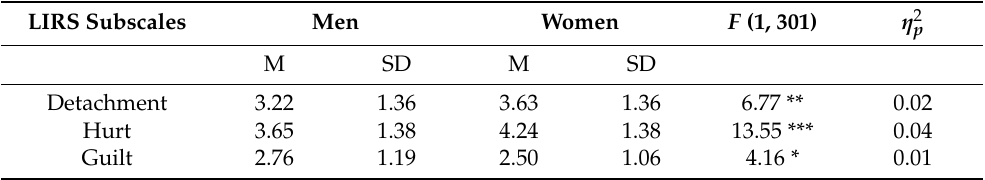
Table 8. Descriptive and Inferential Statistics of LIRS by Gender. LIRS Subscales